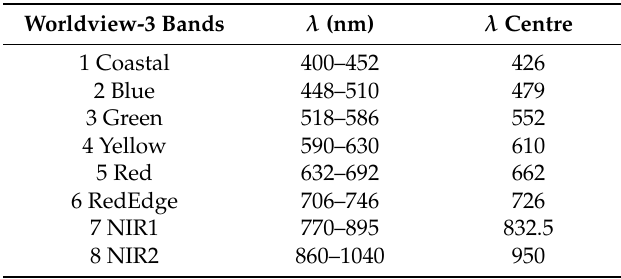
Table 3. Worldview-3 sensor bands showing bandwidths and their wavelength centres in nanometres.